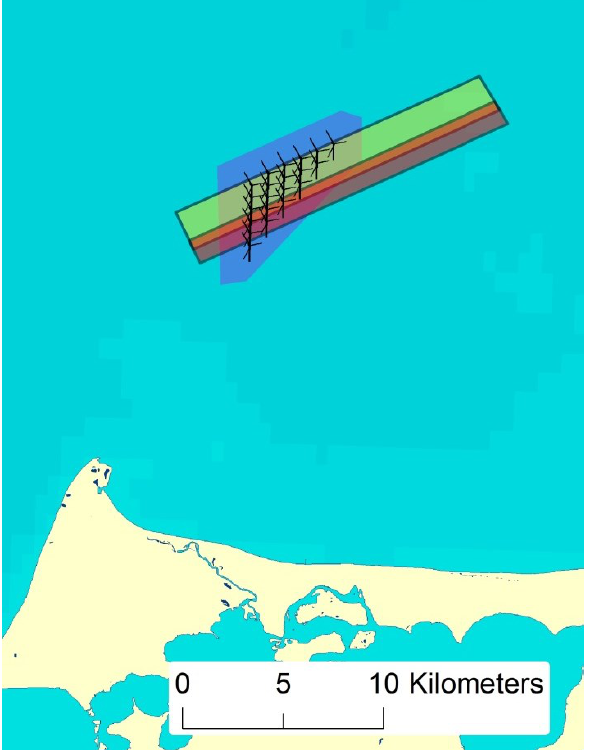
Figure 1. The survey area near offshore wind farm Baltic I in the southern Baltic